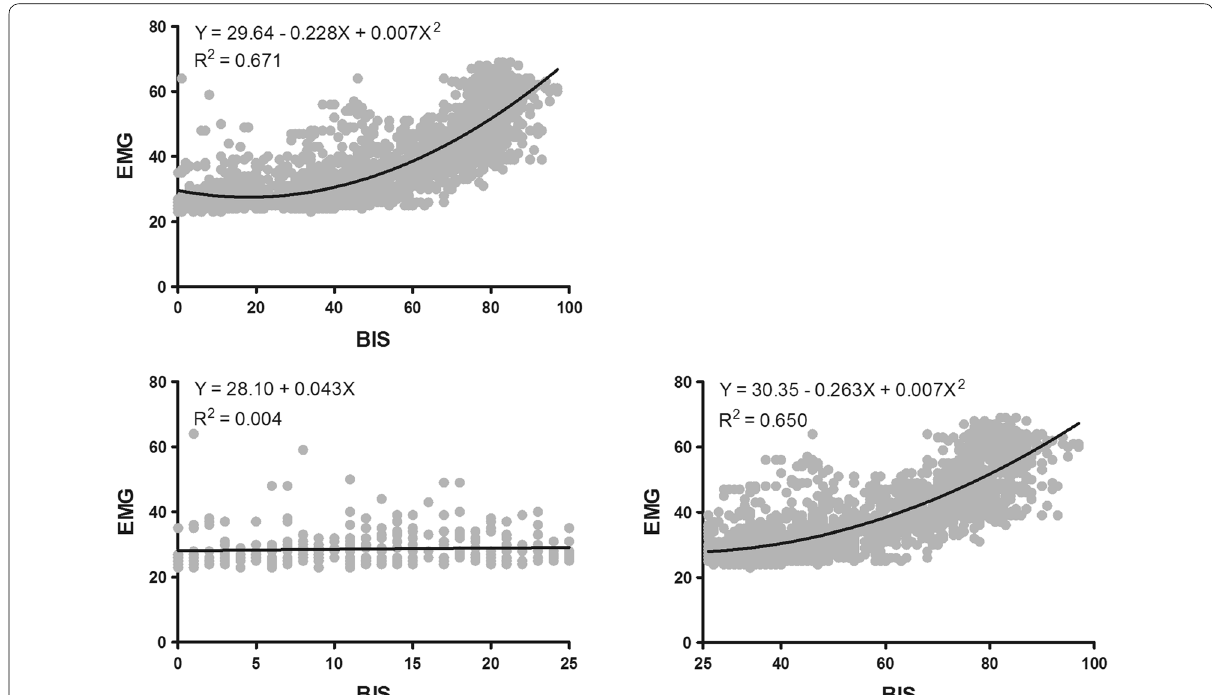
Fig. 3 Correlation between EMG and BIS. The overall relationship between mean EMG and BIS is best described by a quadratic regression curve. No correlation is present between mean EMG and BIS below